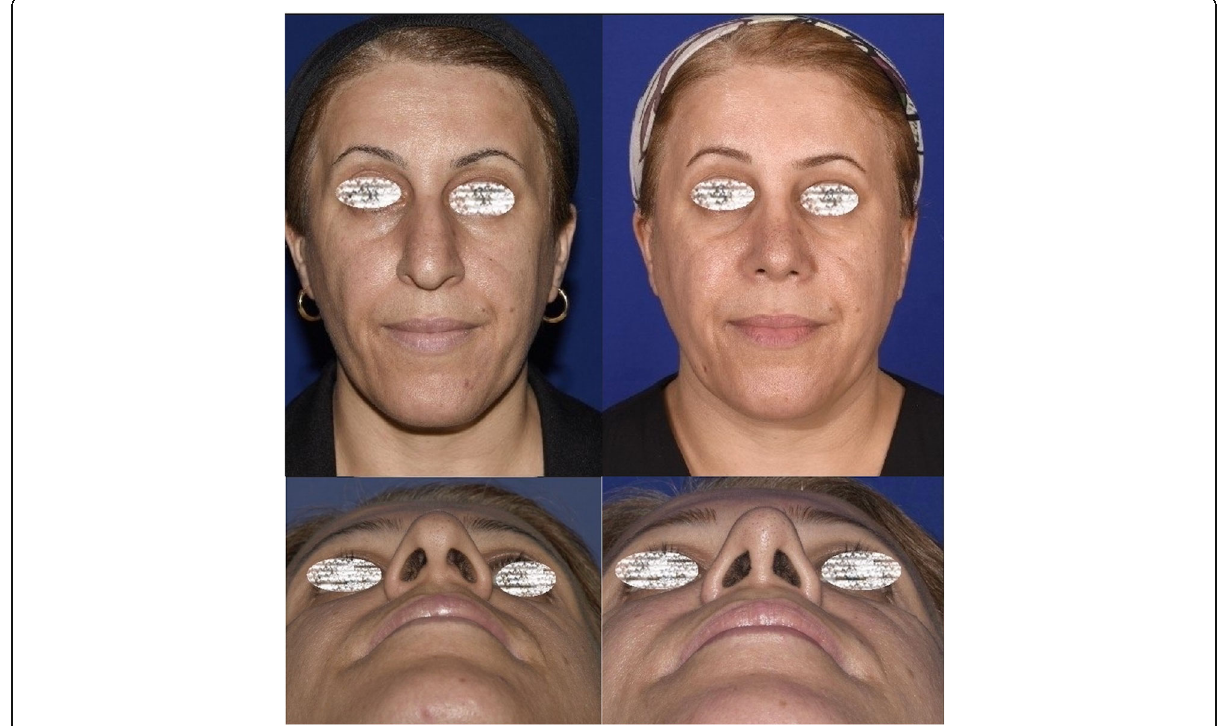
Fig. 3 Patient with congenial asymmetry of the nasal sill area who underwent sill graft procedure. The figure shows preoperative and postoperative views from basal aspect ( a , b ) and frontal aspect ( c , d ). b , d Postoperative views